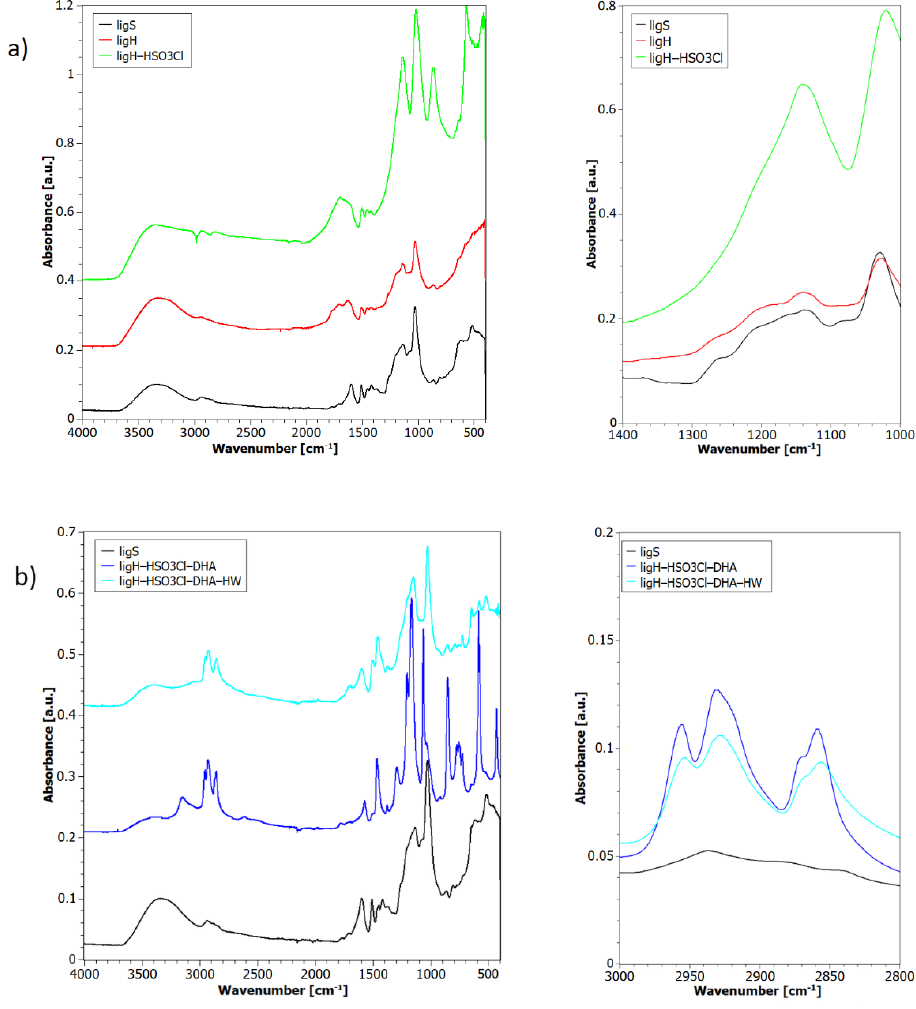
Figure 3. FTIR spectra of the materials obtained after the first ( a ) and the second ( b ) step of the modification